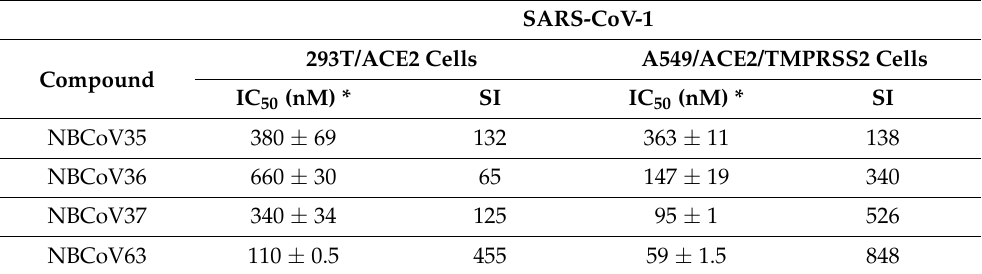
Table 3. Antiviral activity of the NBCoV small molecules in a single-cycle assay in two cell lines against pseudovirus NL4-3 ∆ Env -NanoLuc/SARS-CoV-1 (IC 50 ) and SI.